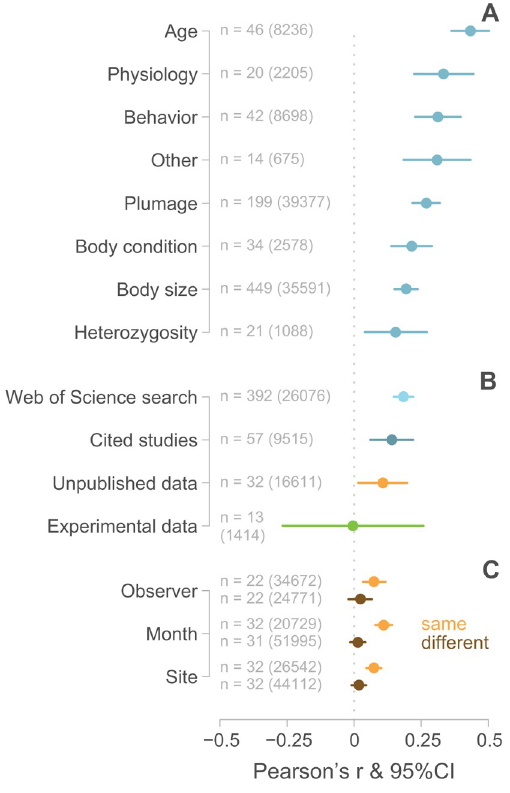
Fig 1. Assortative mating in birds. (A) The magnitude of assortative mating for various traits based on a meta- analysis of the published literature. The data comprise both the “Web of Science search” and the “Cited studies” (see Methods). (B) Strength of assortative mating for size as a function of data source. (C) Strength of assortative mating calculated from previously “Unpublished data” (nine long-term field studies) as a function of measurement context. Dots represent mean Pearson’s correlation coefficients (r), bars the 95% CI (based on S1, S5 and S7 Tables). n indicates the number of estimates for a given trait category, followed by the number of pair–trait combinations in parentheses. The dotted line indicates no assortative mating (r = 0), negative r-values indicate disassortative mating, and positive r- values indicate assortative mating. Underlying data for this figure can be found in S4, S5, and S6 Data.